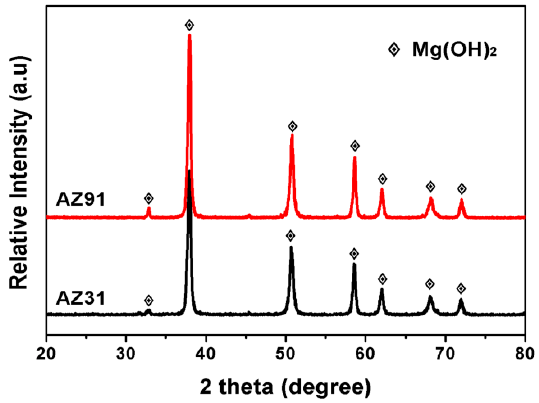
Figure 7. XRD patterns of the uncoated AZ31 and AZ91 Mg alloys after 48 h immersion in 0.1 M NaCl solution.